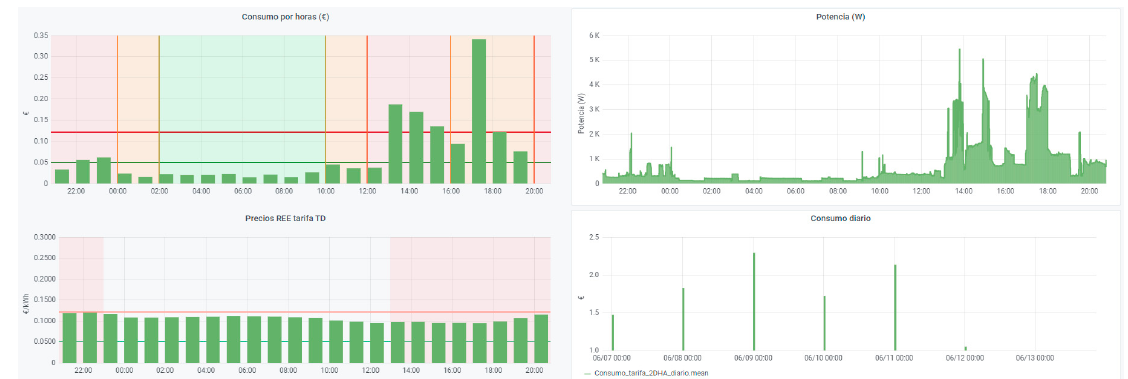
Figure 11. Control Panel excerpt (OpenHAB).